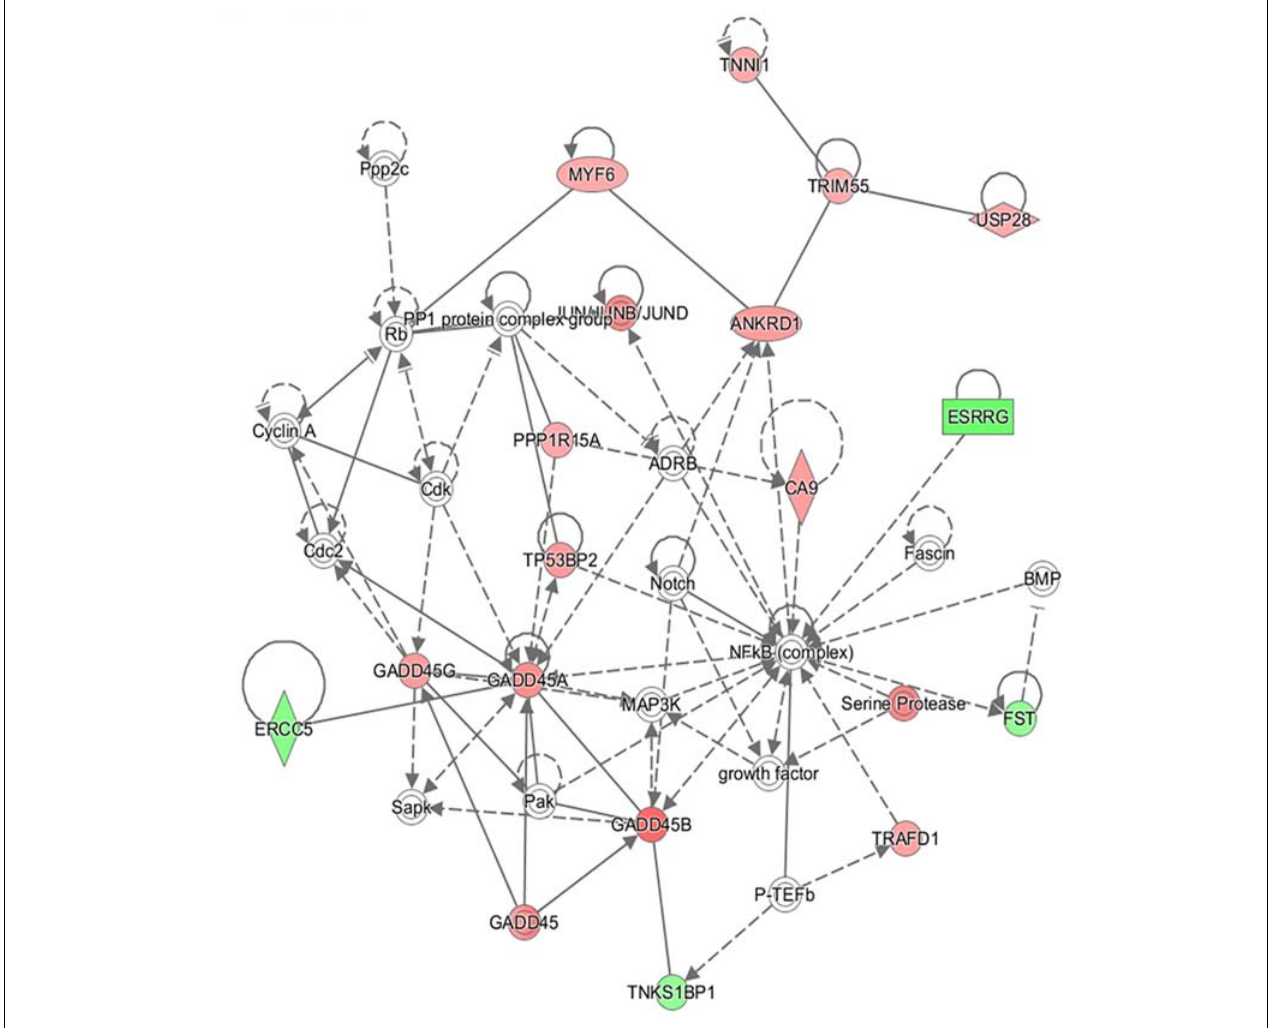
FIGURE 4 | Gene network 2: Cell Cycle, Cellular Growth and Proliferation, Cellular Development. Genes upregulated and downregulated in the H group are represented by green and red colors,